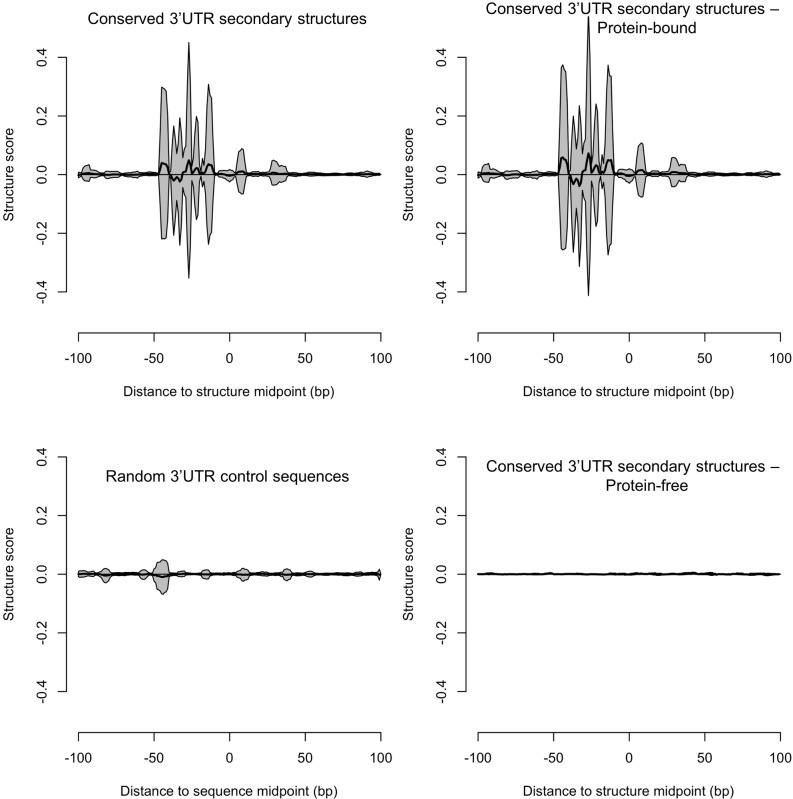
Predicted conserved RNA secondary structures in the 3’UTR have a higher structure score than random 3’UTR control sequences.Using the Structure Surfer database (Berkowitz et al., 2016), we calculated structure scores based on the Parallel Analysis of RNA Structure (PARS). Mean aggregate scores (black lines)±one standard deviation (gray area) were calculated for 200 base pair regions surrounding the midpoint of 5504 predicted conserved secondary structures within 3’UTR regions used in our analysis (top left) (Figure 7, Table 2) and compared with 5504 randomly selected 3’UTR control sequences (bottom left). PARS scores reflect the accessibility of paired and unpaired regions to ribonucleases, with positive scores corresponding to double-stranded RNA and relies on experimental information (Wan et al., 2014). We separated the 5504 predicted conserved secondary structures into those with observed protein binding (top right) (>10 reads in our protein occupancy profiling data) and those without (bottom right). Predicted 3’UTR regions that also showed footprints in our protein occupancy data were enriched for PARS structures, further confirming the validity of the predicted conserved structures.